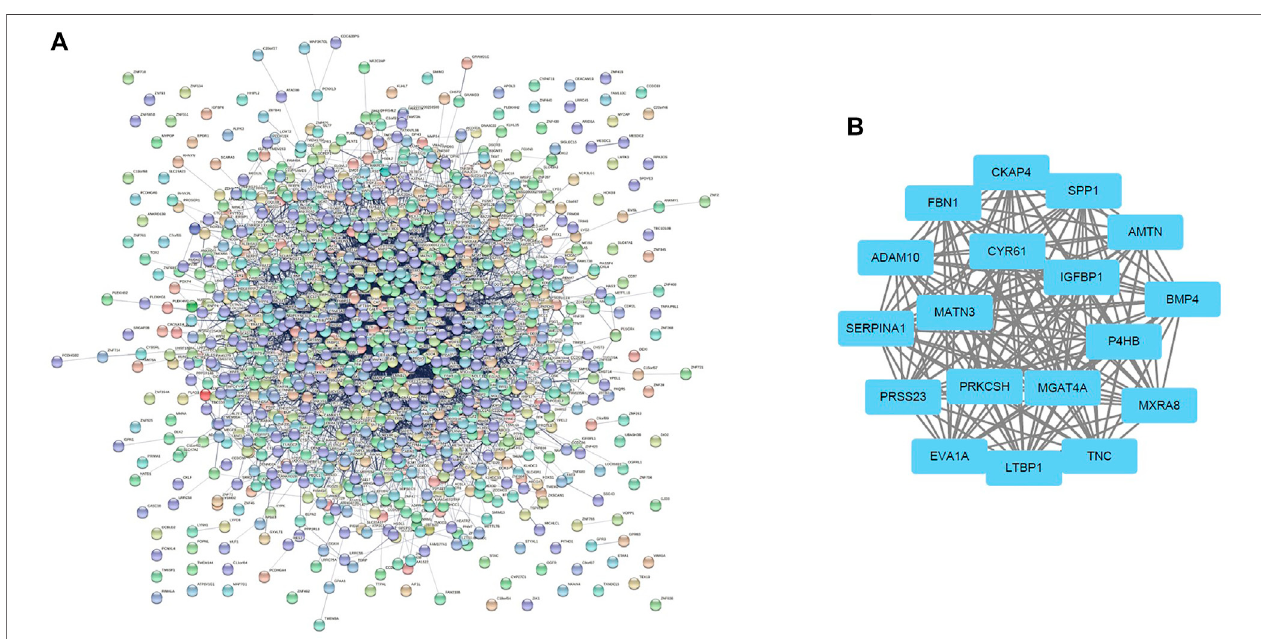
FIGURE 5 | Differential gene expression PPI network construction and module analysis. (A) The PPI network of DEGs constructed using the STRING online database. There were a total of 1,150 DEGs in the PPI network. The nodes represent proteins, and the edges represent protein interactions. (B) Module analysis using MCODE of Cytoscape software: node score cut-off (cid:1) 0.2; max. depth (cid:1) 100; k-core (cid:1) 10. DEGs: differentially expressed